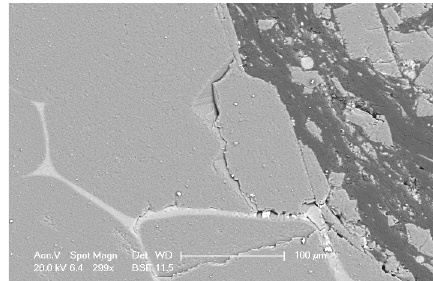
Figure 5: BIC change rate of each model number.